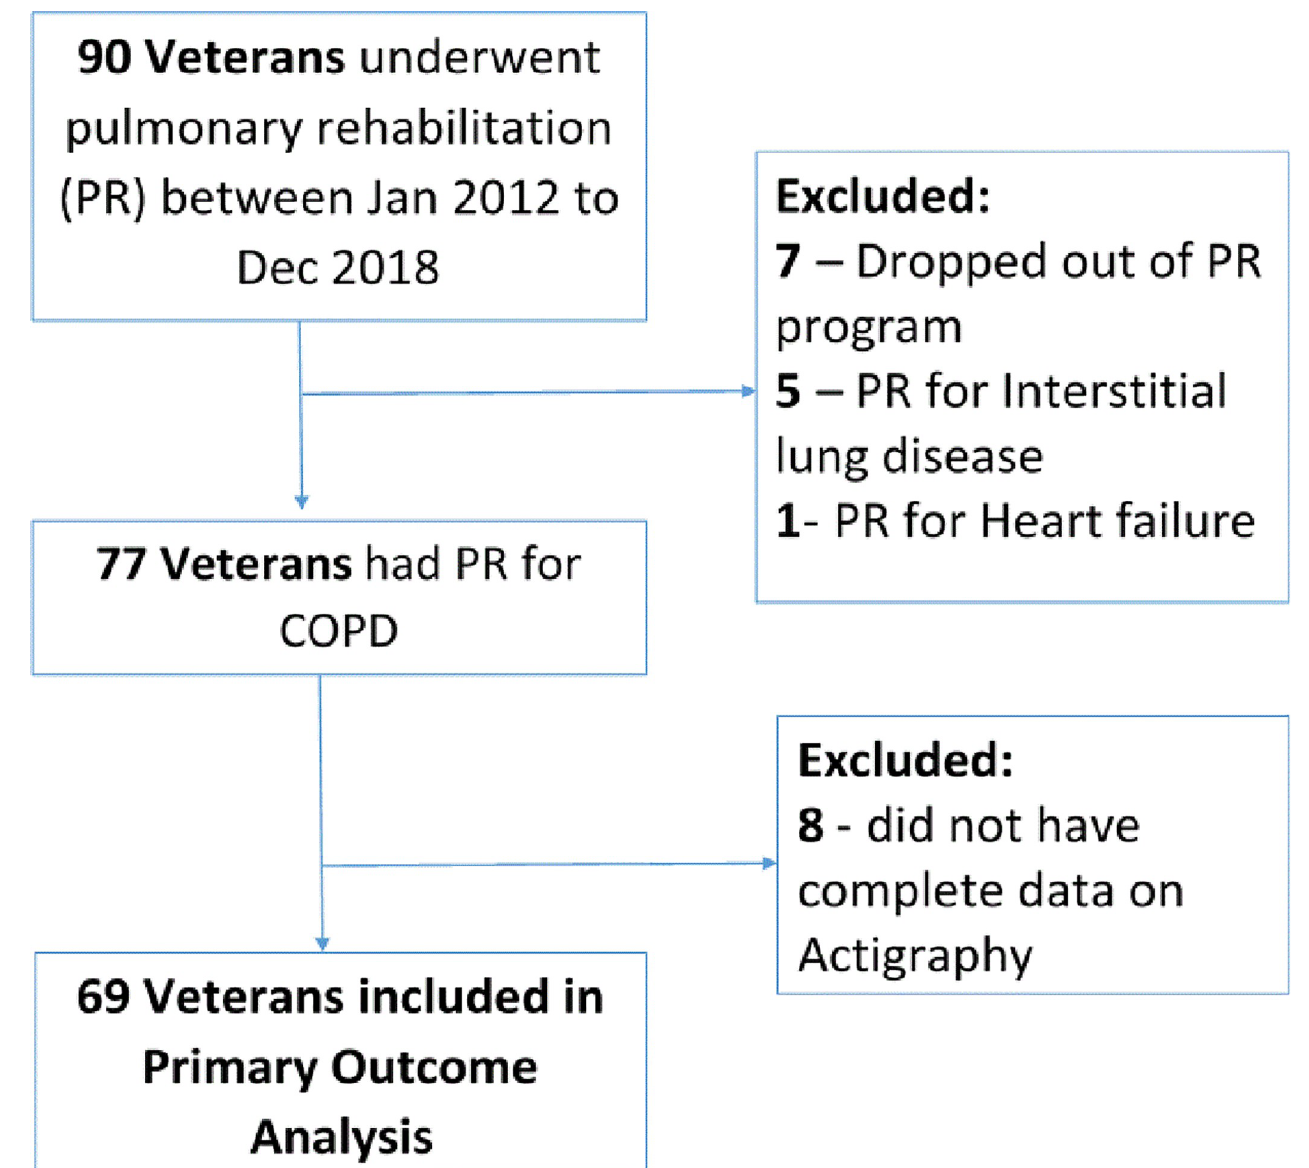
Fig 1. Study flow